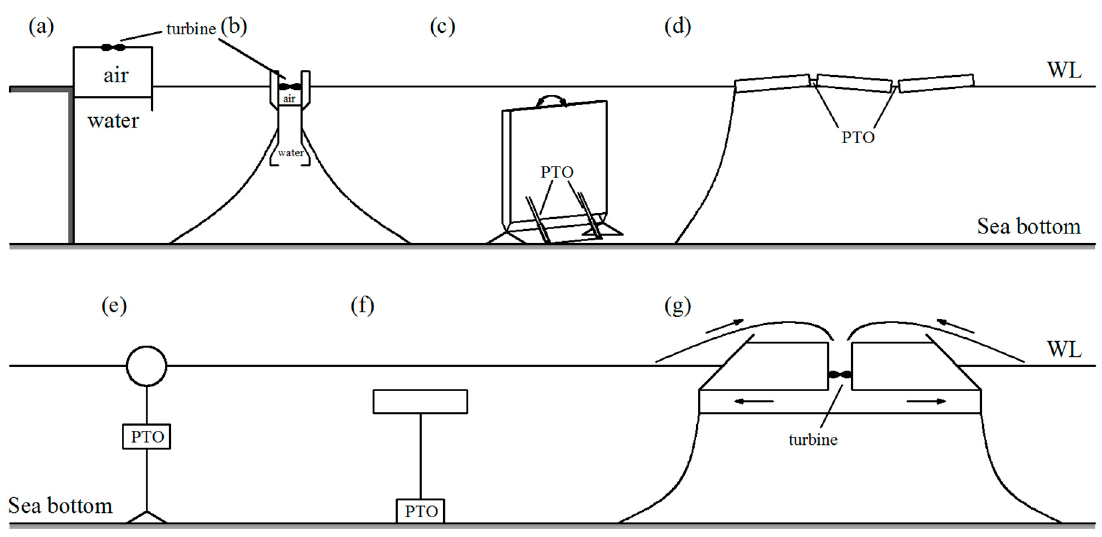
Figure 6. WEC technologies.